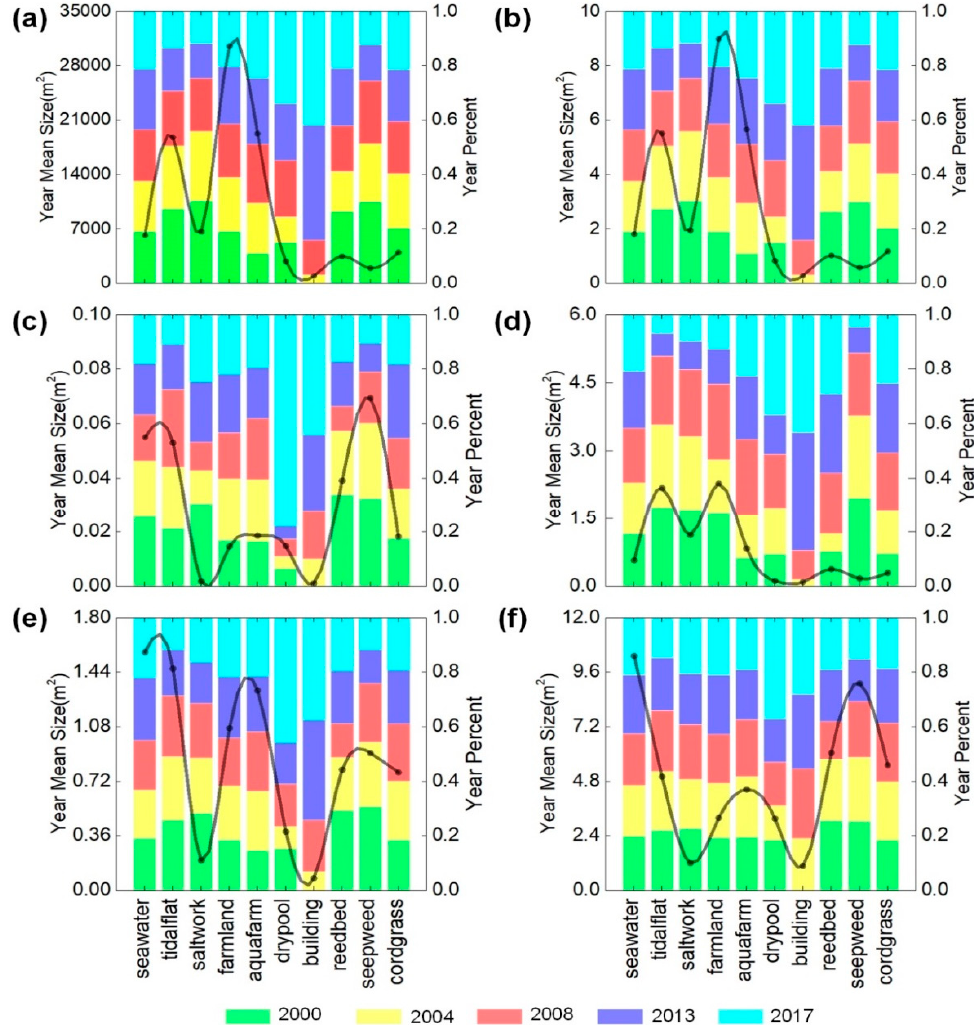
Figure 5. Overall characteristics of landscape types. ( a ) CA; ( b ) PLAND; ( c ) PD; ( d ) LPI; ( e ) ED; and ( f ) LSI. To fully reflect the characteristics of the landscape pattern and to reduce the redundancy of the pattern information, the landscape metrics at landscape level were selected, and the characteristics of the landscape pattern were analyzed using the FRAGSTATS 4.2 selection method.